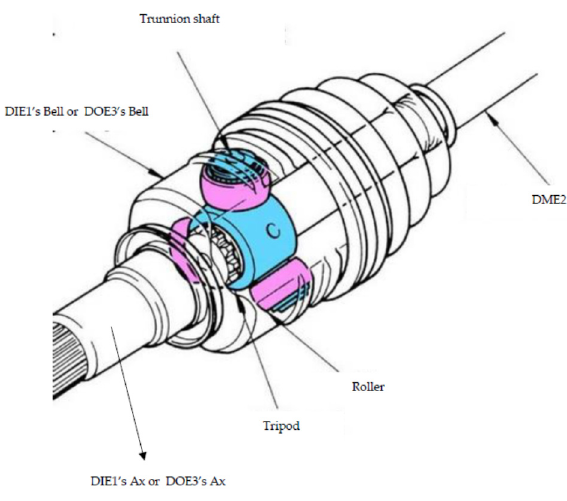
Figure 4. The tripod joint of a DTID in detail.